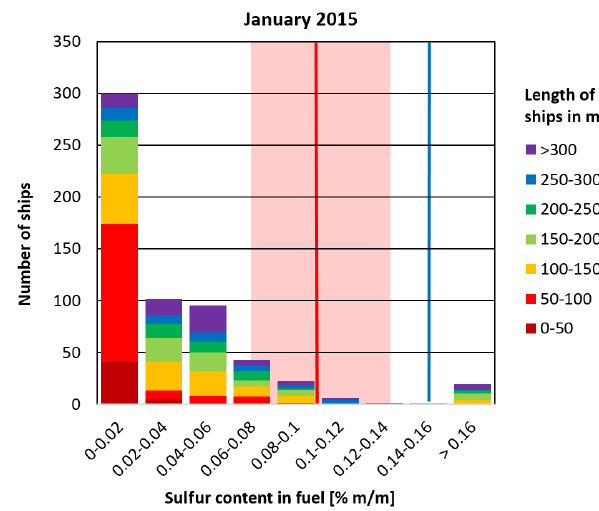
Figure 4. Detailed view of the January 2015 data set. The lengths of the ships are colour-coded; the red line indicates the 0.1% limit, with the shaded area representing the upper limit uncertainty of 30%. The blue line indicates the suggested limit of 0.15% for flag- ging ships as exceeding the sulfur fuel content limit